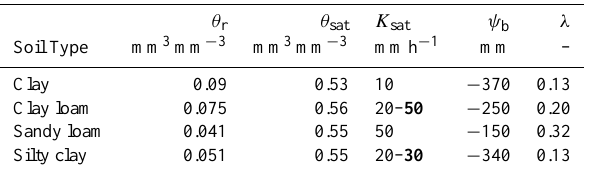
Table 2. Hydraulic soil properties for the four soil types present in the Mameyes Basin. For clay loam and silty clay, column 4 reports the range of variability of K sat with depth used in testing the model (see Sect. 5); in bold are the hydraulic conductivity values actually used in the final experiments (Sect.